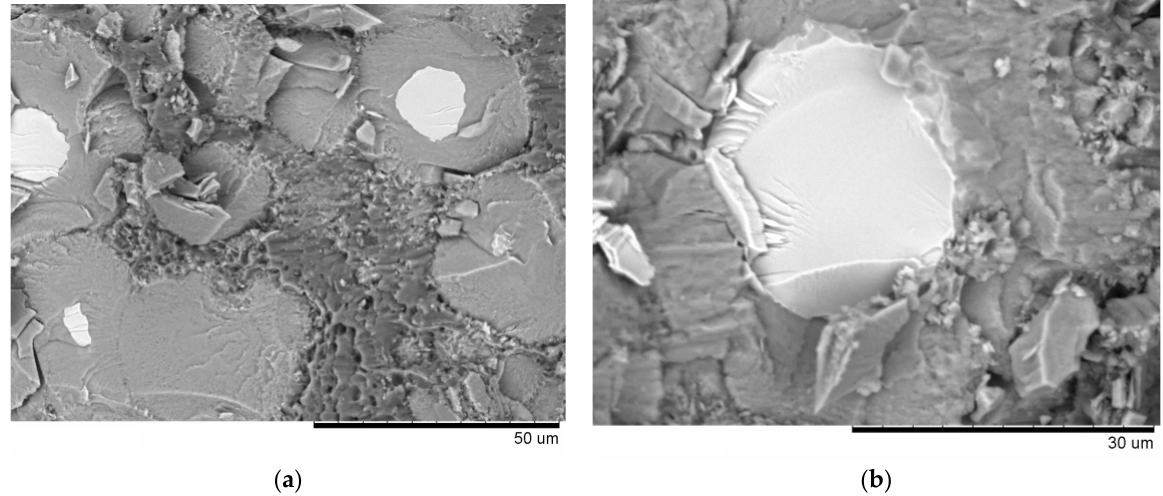
Figure 8. Fracture surface of the composite sintered at 570 °C, 3 min, after compression test: ( a ) an area showing Fe-based alloy particles, reaction products and residual Al matrix, ( b ) an area showing a Fe-based alloy particle and reaction products. BSE images.